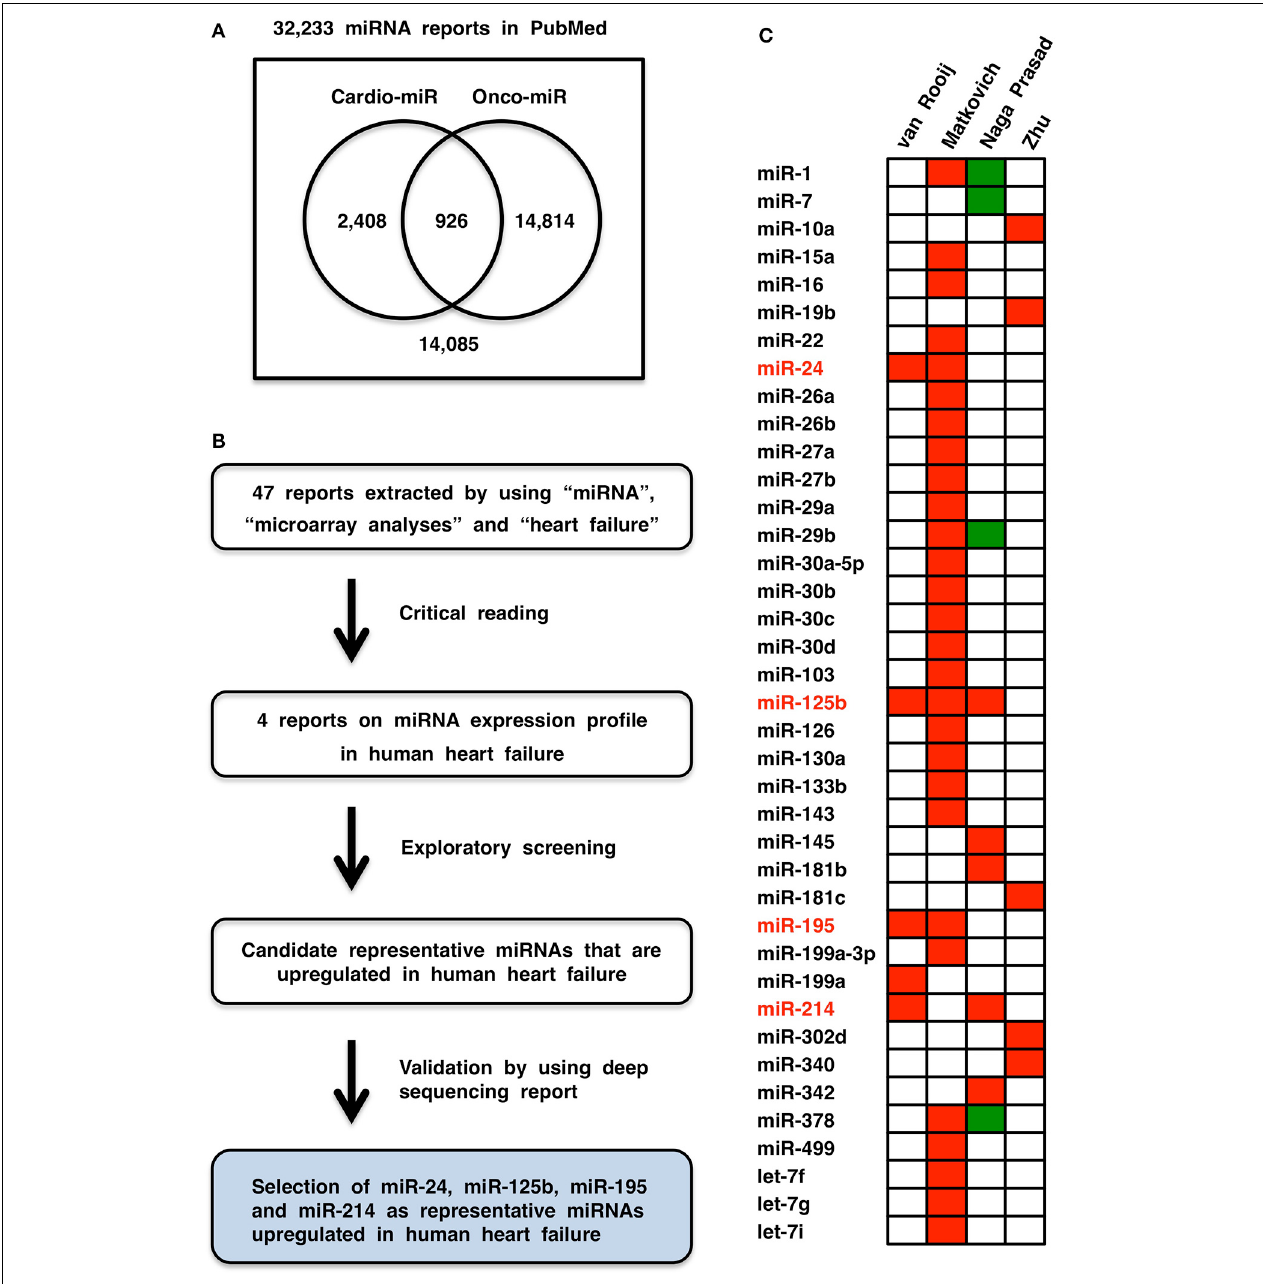
FIGURE 1 | Cardio-miRNAs upregulated in human heart failure. (A) Bibliology of miRNAs, cardio-miRs, and onco-miRs. (B) Flowchart of representative cardio-miR selection. Based on exploratory screening of miRNA expression reports (van Rooij et al., 2006; Matkovich et al., 2009; Naga Prasad et al., 2009; Zhu et al., 2013) and validation process utilizing